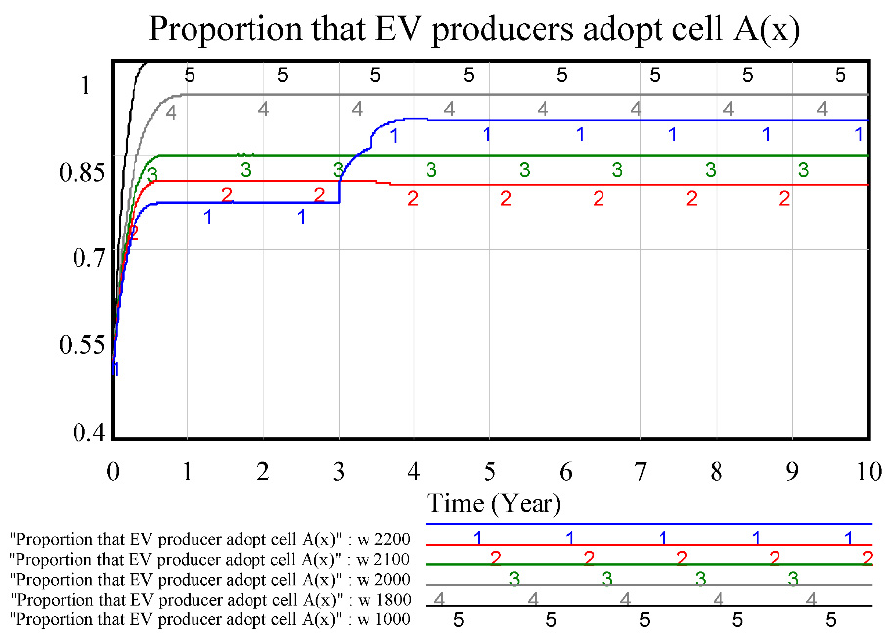
Figure 8. Sensitivity test of factor w that impacts EV producer.